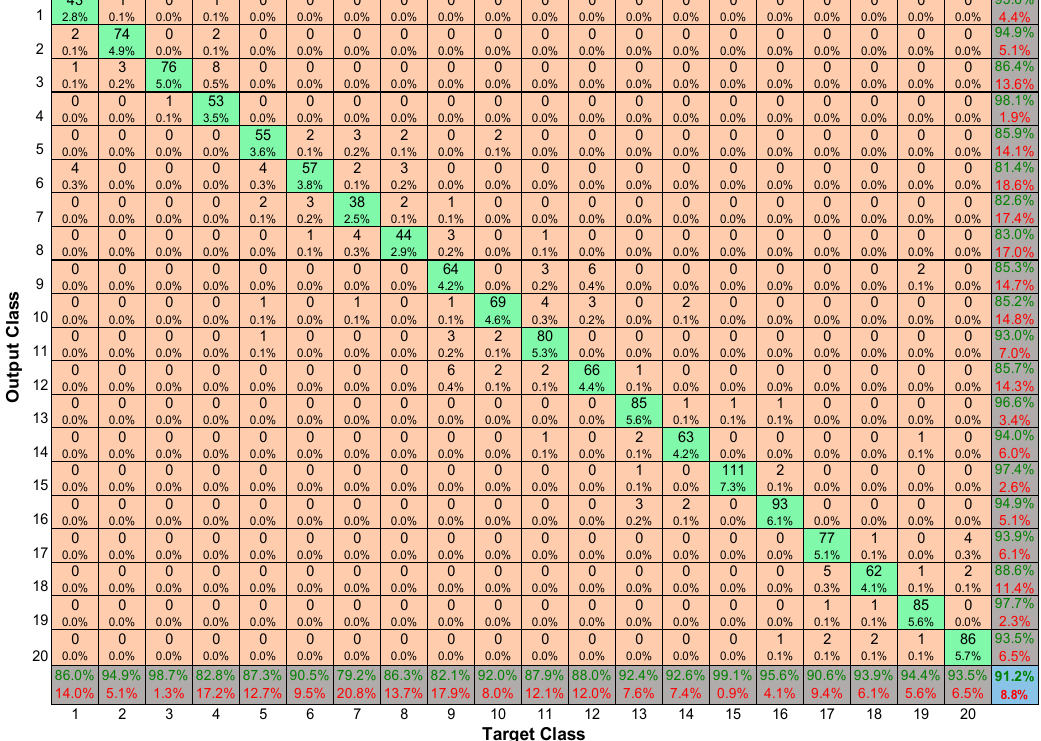
Figure 12. Confusion matrix for the artificial neural network (ANN) model.